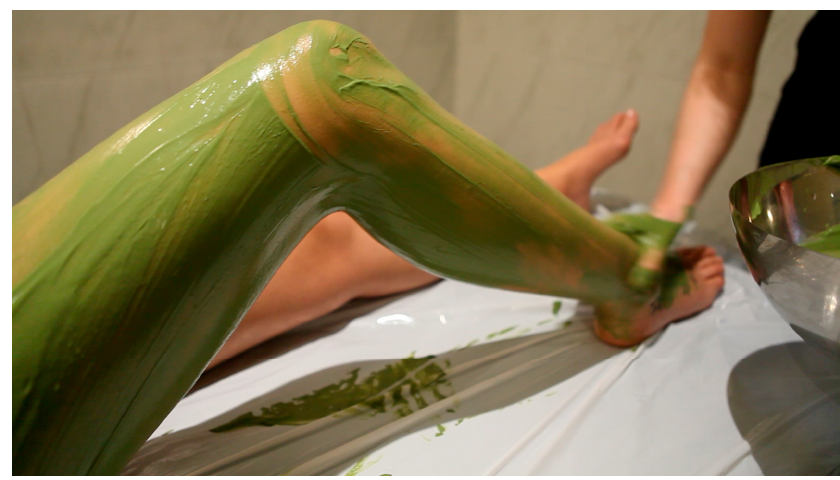
Figure 3. Marine mud (microalgal peloid) application (Talaso Atlántico, Oia, Pontevedra, Spain).